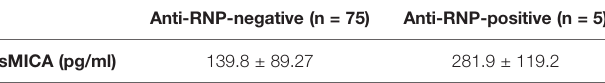
TABLE 4 | Increased circulating sMICA concentrations in SLE patients positive for anti-RNP